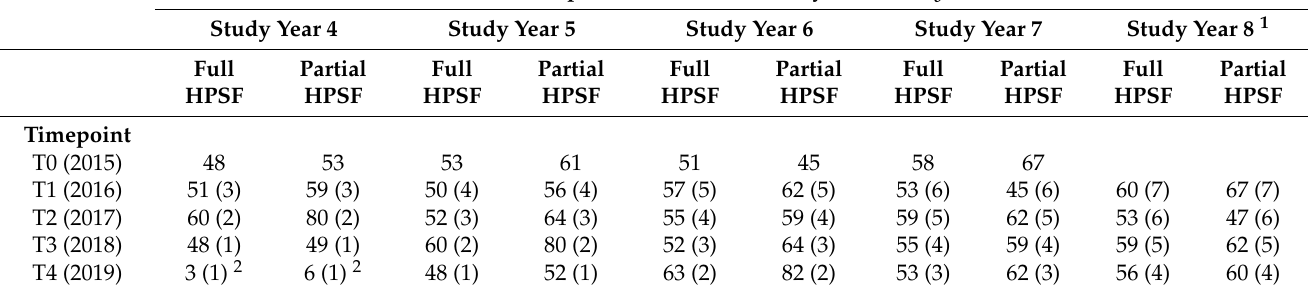
Table 1. Participants included in the present study, specified for T0–T4. Number of Included Participants, Divided Per Study Year (Study Year at T0 in